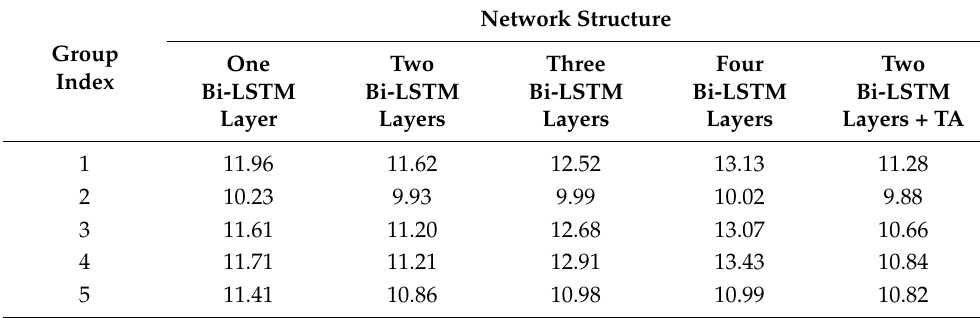
Table 5. RMSE of different network structures (units: